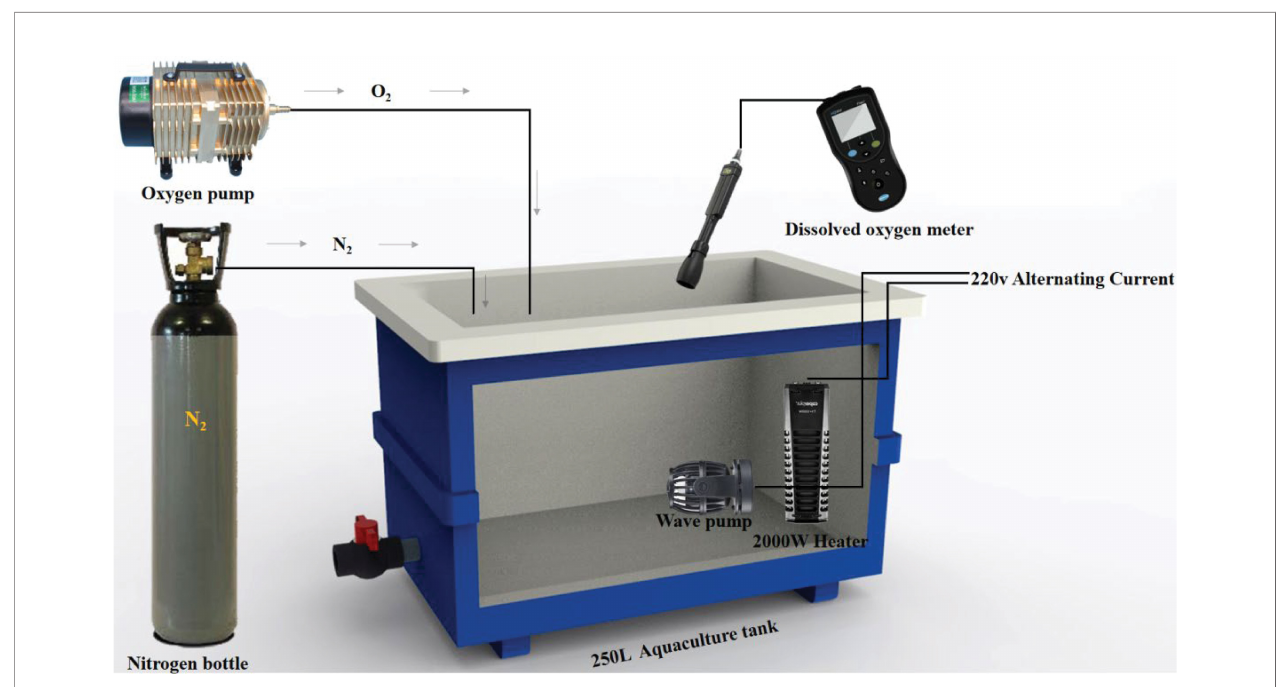
FIGURE 1 | Temperature dissolved oxygen control